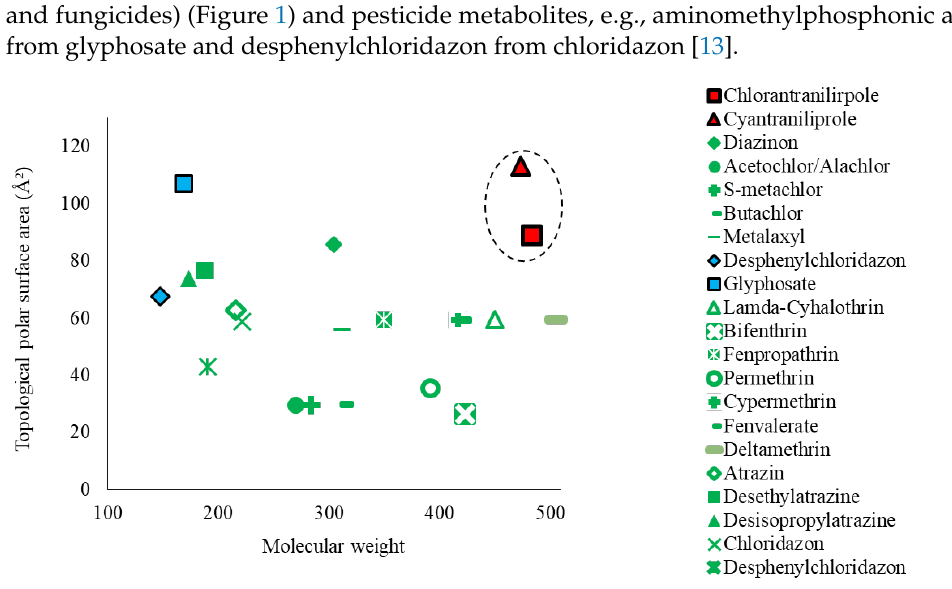
Figure 1. Distribution of diverse pesticides chemicals based on molecular characteristics and their analytic equipment, such as LC (or GC) – IRMS with blue symbols, GC – IRMS with green symbols alytic equipment, such as LC (or GC)–IRMS with blue symbols, GC–IRMS with green symbols [7–13], and EA–IRMS with red symbols (in this study) for stable isotope